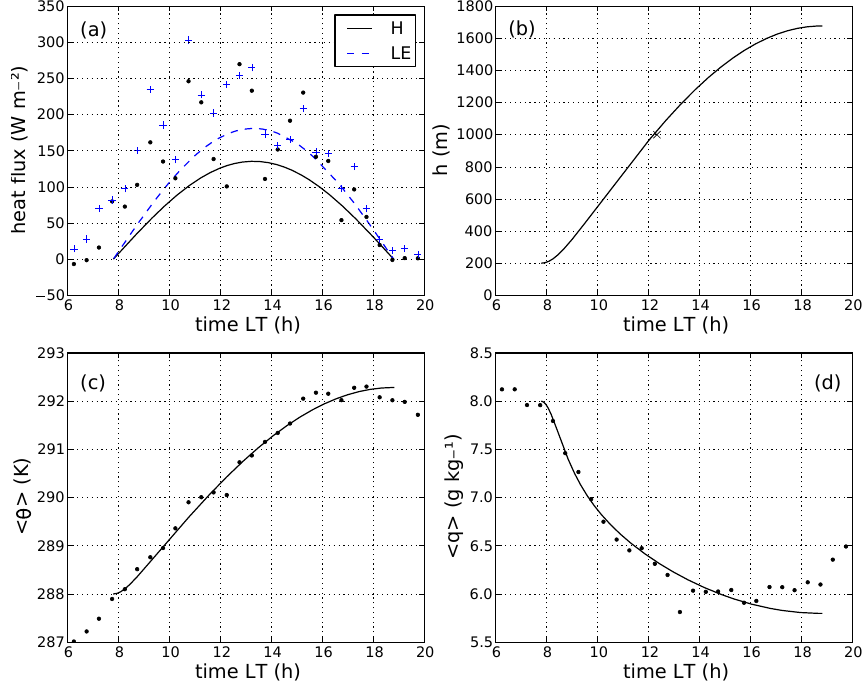
Fig. 3. Diurnal evolution of (a) surface sensible (H) and latent (LE) heat flux, which are both prescribed, (b) boundary layer height ( h ), (c) mixed layer potential temperature ( h θ i ) and (d) mixed layer specific moisture ( h q i ) for the case study. Dots and crosses indicate tower (at 67.2m) and balloon measurements, respectively. Model results are indicated by